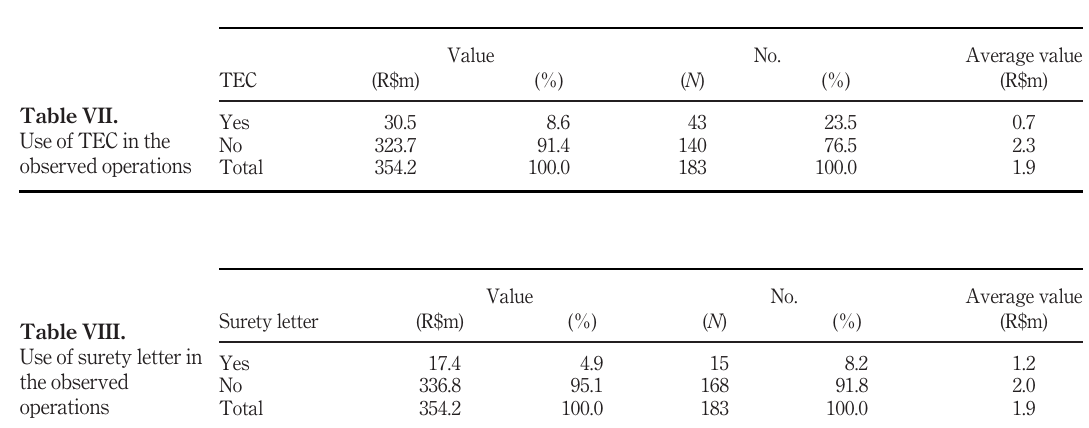
Table VIII. Use of surety letter in the observed operations